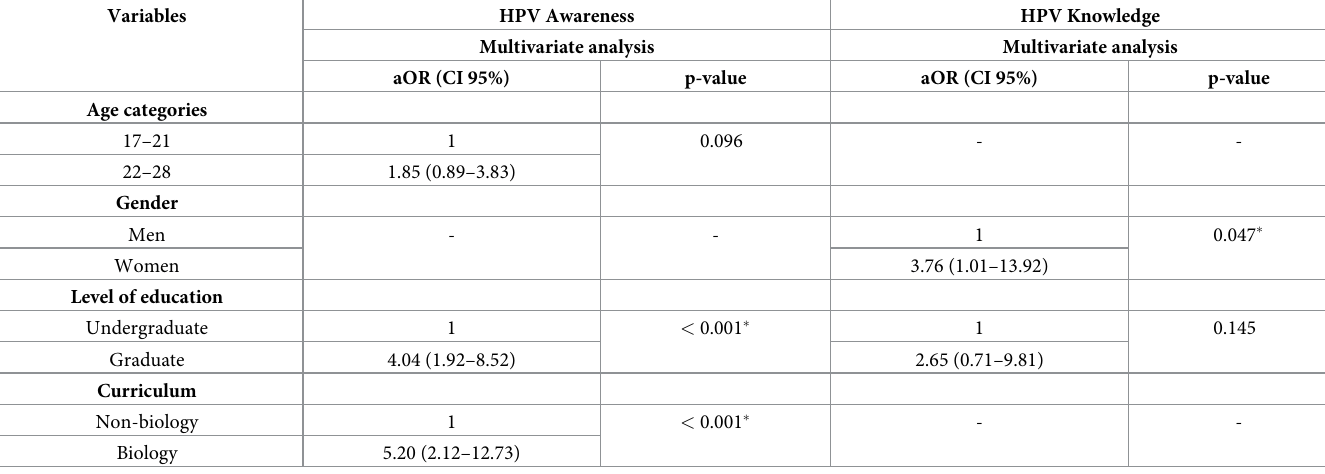
Table 3. Multivariate logistic regression analysis to examine the factors associated with HPV awareness and